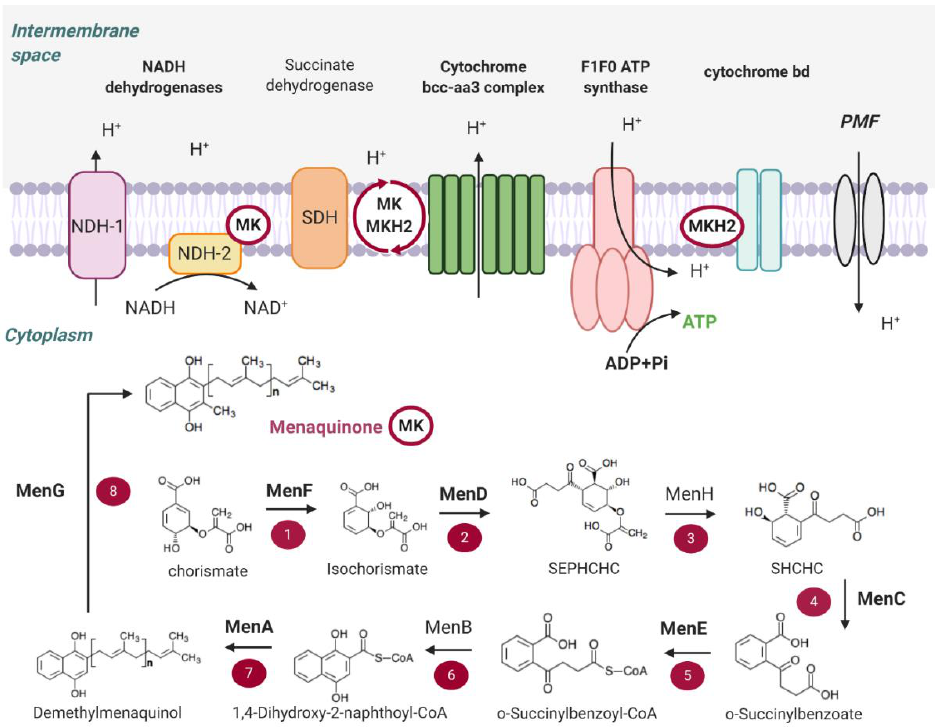
Figure 1. Schematic representation of the Mycobacterium tuberculosis ( M. tb ) electron transport chain (ETC) and menaquinone (MK) biosynthesis pathway. Electrons provided by NADH are fuelled to the